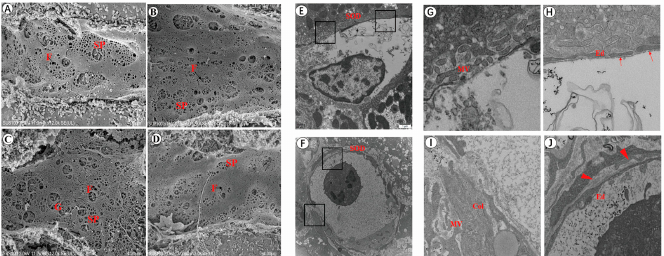
Figure 2. The structure of LSEC fenestration was altered in the liver of mice following infection. ( A ) The number of LSEC fenestration in the uninfected group. ( B ) The number of LSEC fenestration for 20 days after infection. ( C ) The number of LSEC fenestrations for 28 days post infection. ( D ) The number of LSEC fenestrations for 42 days post infection. ( E ) The structure of the LSEC basement membrane in the uninfected group. ( F ) The structure of the LSEC basement membrane for 42 days post infection. ( G ) The number of microvilli in the hepatic disc space of the uninfected mice (TEM magnification). ( H ) The structure of the LSEC basement membrane in the uninfected group (TEM magnification). ( I ) The number of microvilli and collagen in the hepatic disc space for 42 days post infection (TEM magnification). ( J ) The LSEC basement membrane structure for 42 days post infection (TEM magnification). SP, sieve plate; F, fenestration; G, gap; Ed, sinusoidal endothelial cells; BM, basement membrane; SOD, space of Disse; MV, microvilli; Col, collagen; small arrow, fenestration; big arrow, basement membrane.